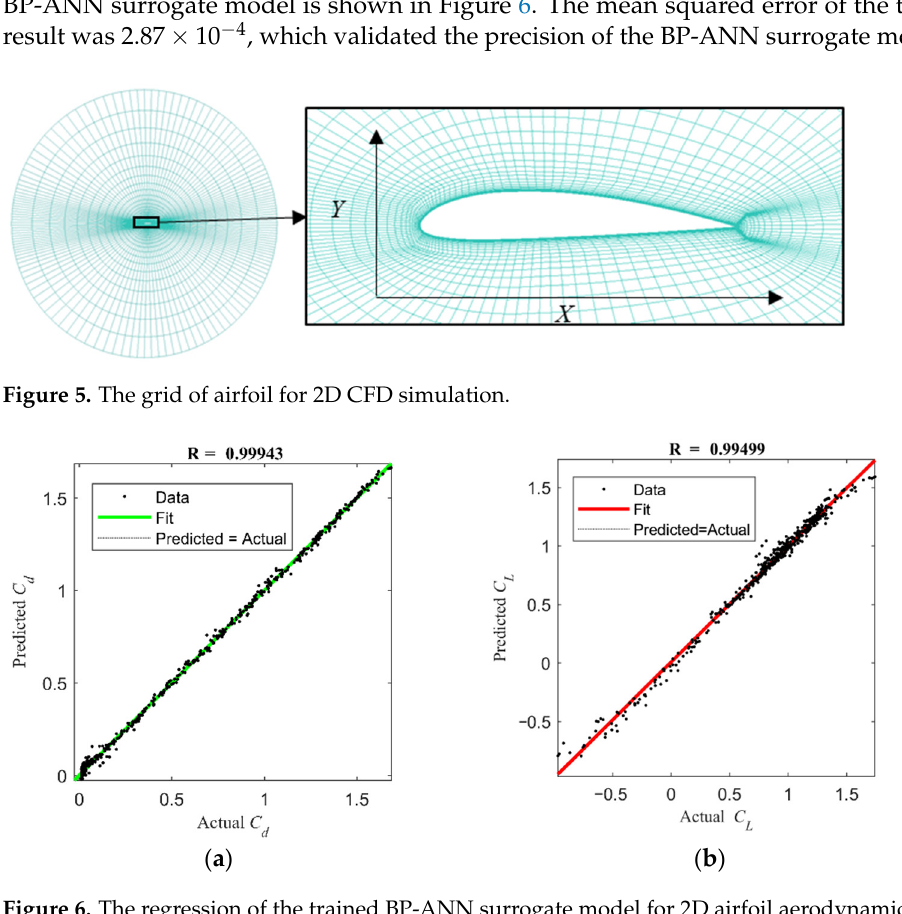
Figure 7. The distribution of chord-length, twist angle and relative thickness of a 3-blade NACA 5868-9 propeller.